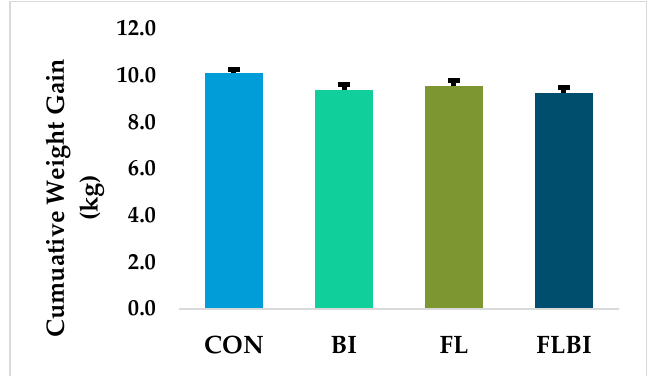
Figure 1. Total body weight gain of piglets. Total body weight gain between PND 2 from PND 33. Data are expressed as means ± SEM. n = 12–15. Experimental treatment tended ( p = 0.075) to impact total weight gain. Abbreviations: BI, control diet + 10⁹ CFU Bi -26/day; CON, control diet; FL, control formula + 1.0 g/L 2'-FL; FLBI, control formula +1.0 g/L 2'-FL + 10⁹ CFU Bi -26/day; PND, postnatal day; SEM, standard error of the mean.